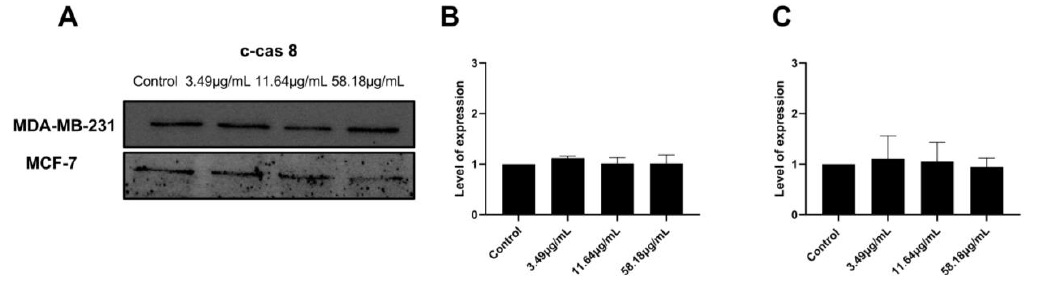
Figure 5. ScBEE does not activate the extrinsic pathway. Western blot analysis ( A ) showed no signifi- cant effect of the extract on the expression of c-caspase 8 in ( B ) MDA-MB-231 and ( C ) MCF-7 cells. Significant differences are reported; * indicates a p-value of 0.01 < p < 0.05, ** indicates a p- value of 0.001 < p < 0.01 and *** indicates a p-value of 0.0001< p < 0.001. The full-length blots of all trials are reported as Supplementary Figures S7 and S8.